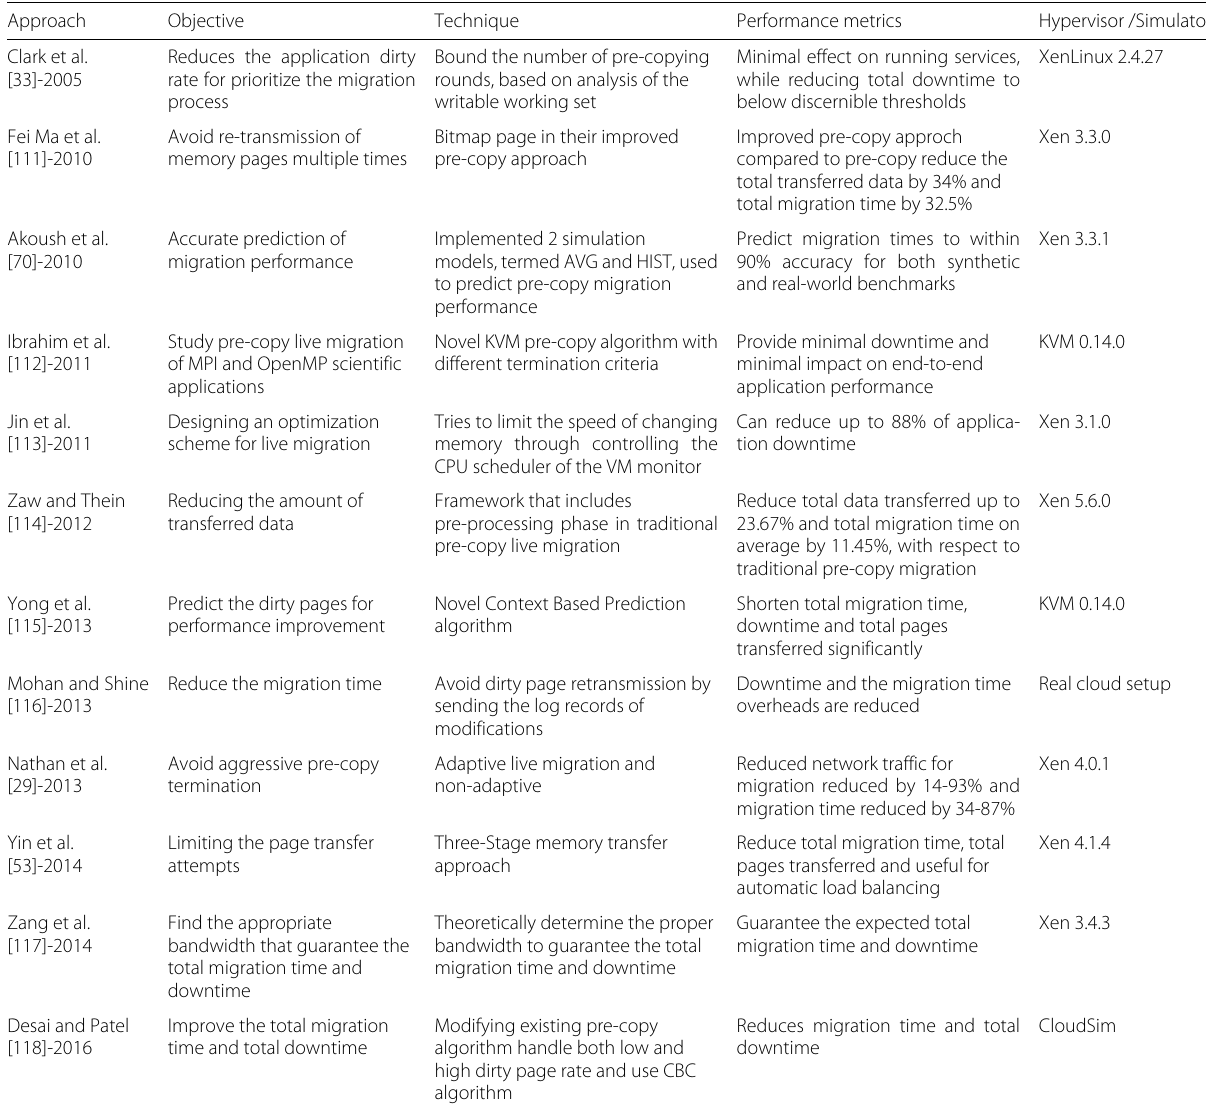
Table 12 Comparison of Dirty page aware VM migration approaches